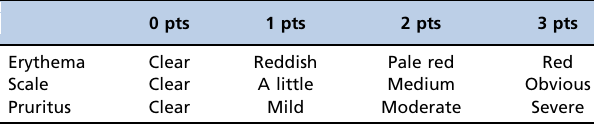
Table 1 - Scoresheet of Symptoms and Signs of Seborrheic